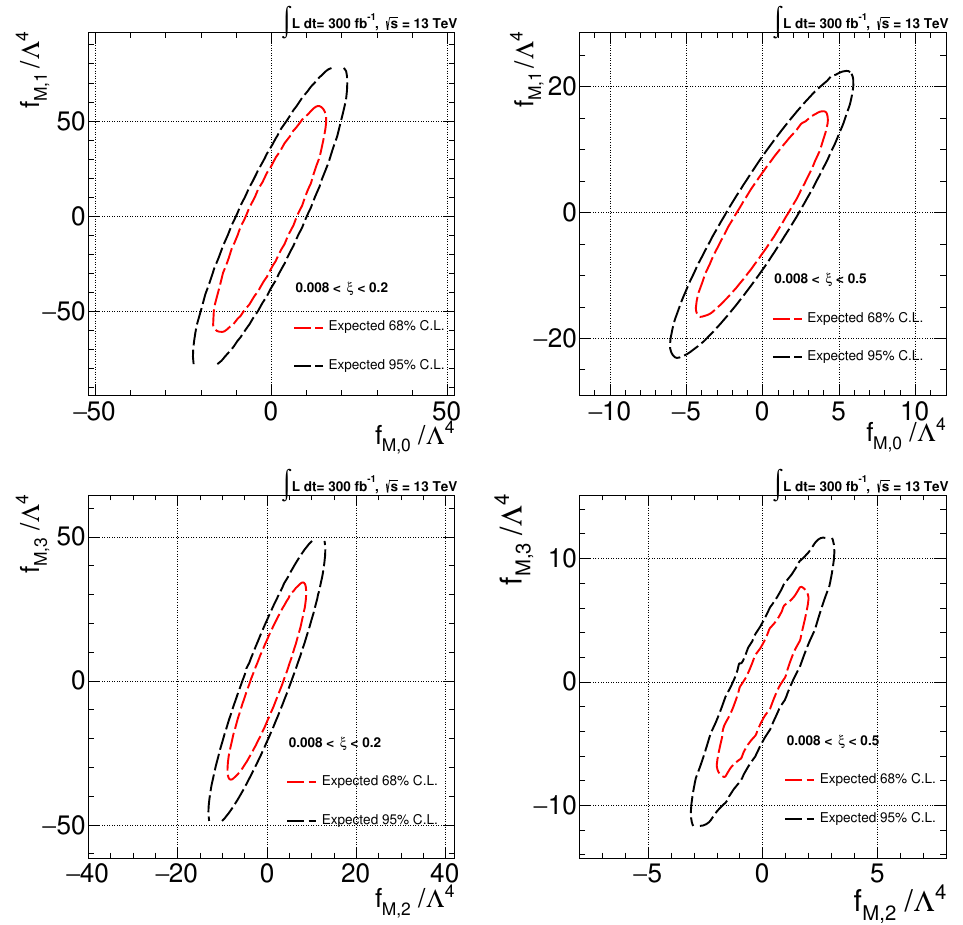
Figure 12 . Two-dimensional 68% and 95% C.L expected allowed regions between f M; 1 and f M; 0 for acceptance of 0.008 < (cid:24) < 0.2 (top-left) and 0.008 < (cid:24) < 0.5 (top-right). Also Two-dimensional allowed region for f M; 3 and f M; 2 for acceptance of 0.008 < (cid:24) < 0.2 (bottom-left) and 0.008 < (cid:24) < 0.5 (bottom-right) assuming 300 fb (cid:0) 1